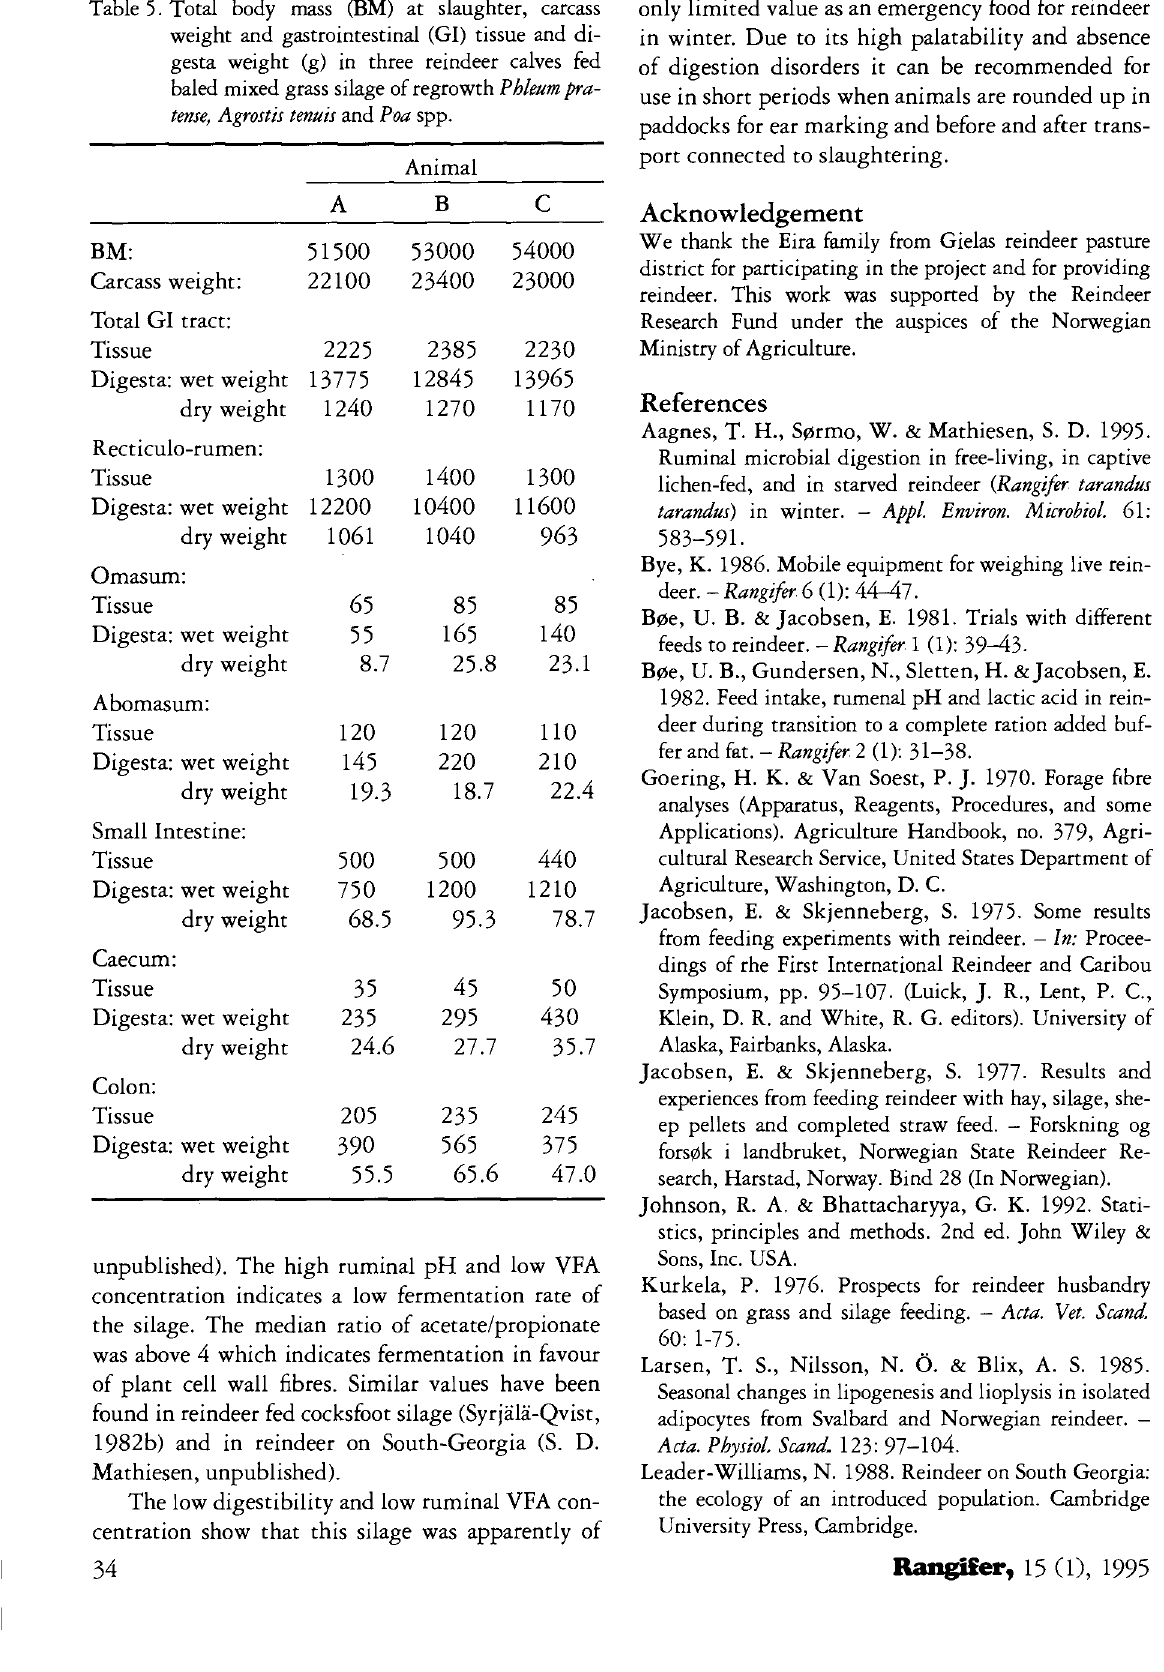
Table 5. Total body mass (BM) at slaughter, carcass weight and gastrointestinal (GI) tissue and di gesta weight (g) in three reindeer calves fed baled mixed grass silage of regrowth Phleum pra- tense, Agrostis tenuis and Poa